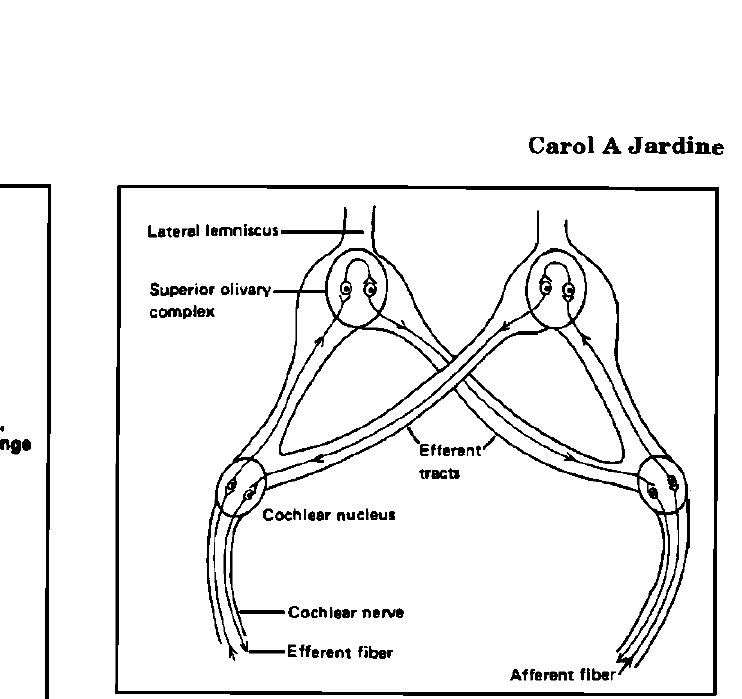
Figure 5. The cochlear efferent system originat- ing from the oliviocochlear nucleus in the supe- rior olivary